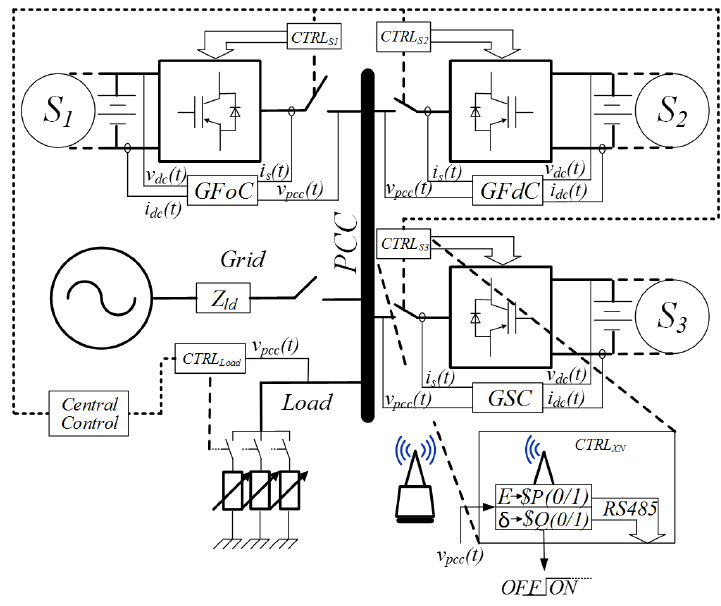
Figure 10. An autonomous decentralized AC MG general